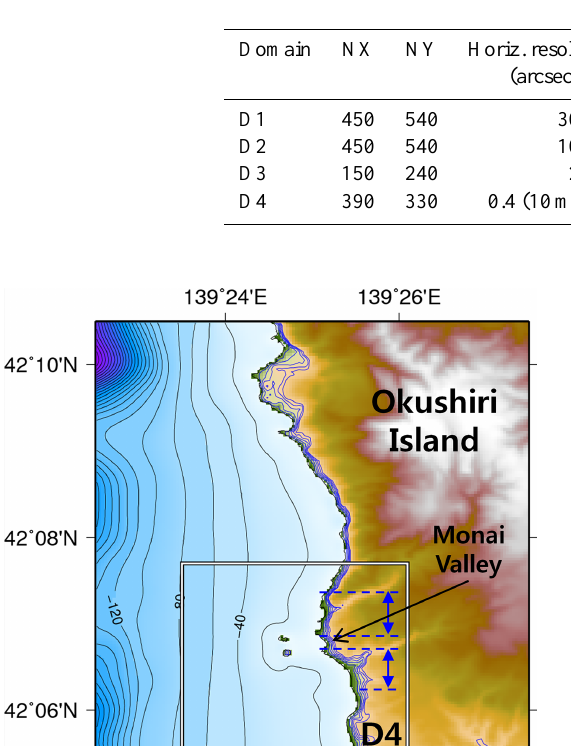
Table 1. Information on grids and time steps.